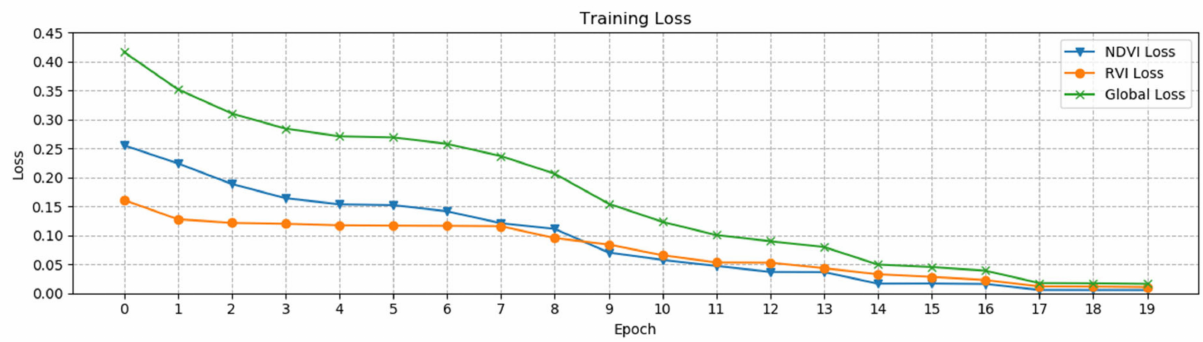
Figure 9. The training curve of the unsupervised learning based model for domain knowledge